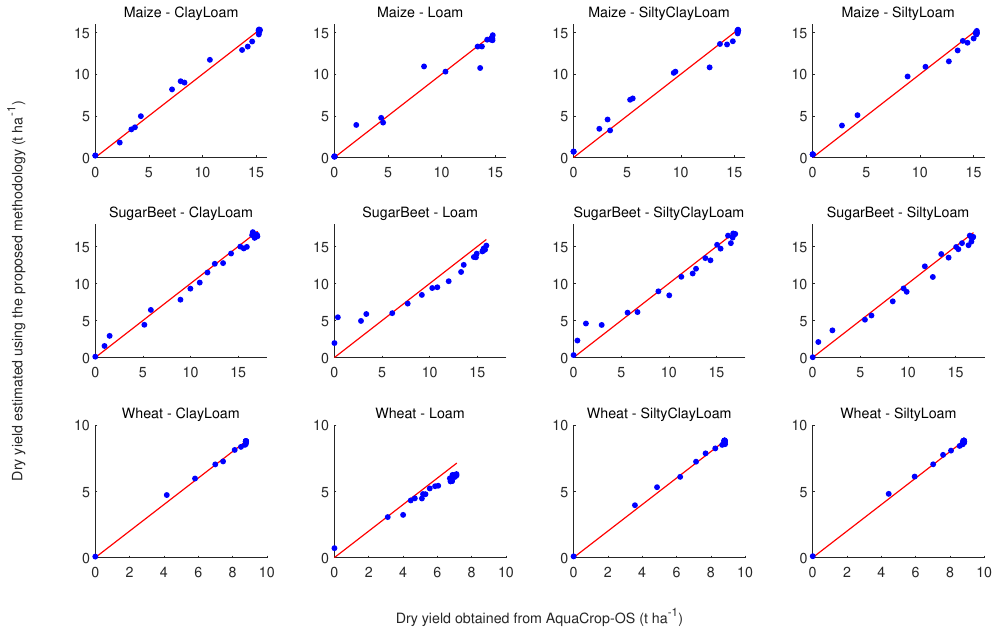
Figure 8. Crop yield (Y) obtained from the benchmarking for maize, sugar beet, and wheat in various soil types considering the mean value of bulk density in the year 2014. Red lines present the benchmark estimated by AquaCrop-OS, while each blue dot corresponds to the crop yield estimated by the proposed methodology. Table 3. Yield response factor ( Ky ) obtained for maize, sugar beet, and wheat in various soil types considering the mean value of bulk density, valid for the years 2010–2014. Crop